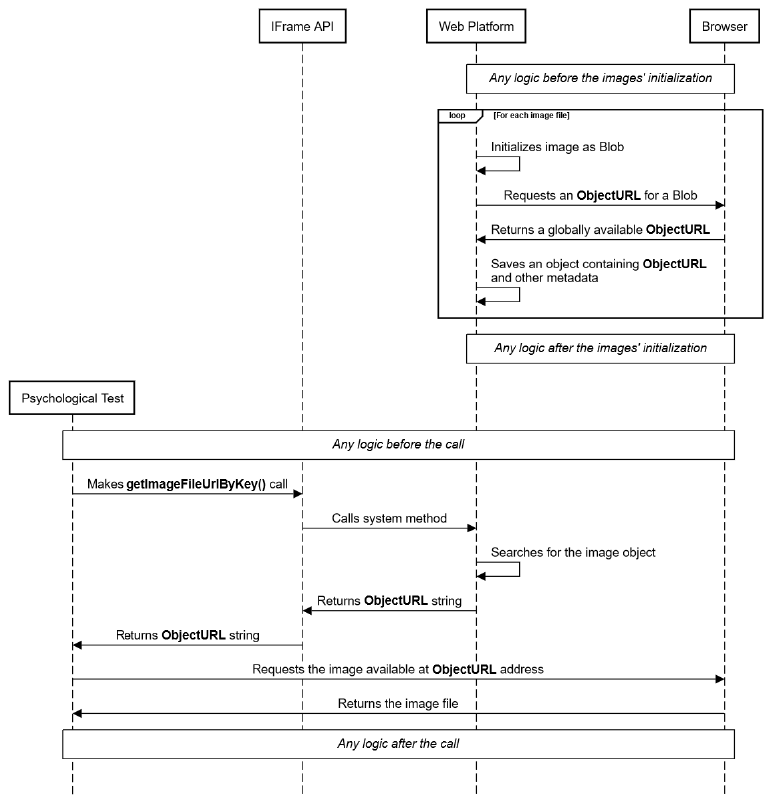
Figure 5. Sequence diagram of the procedure for accessing an image resource file.